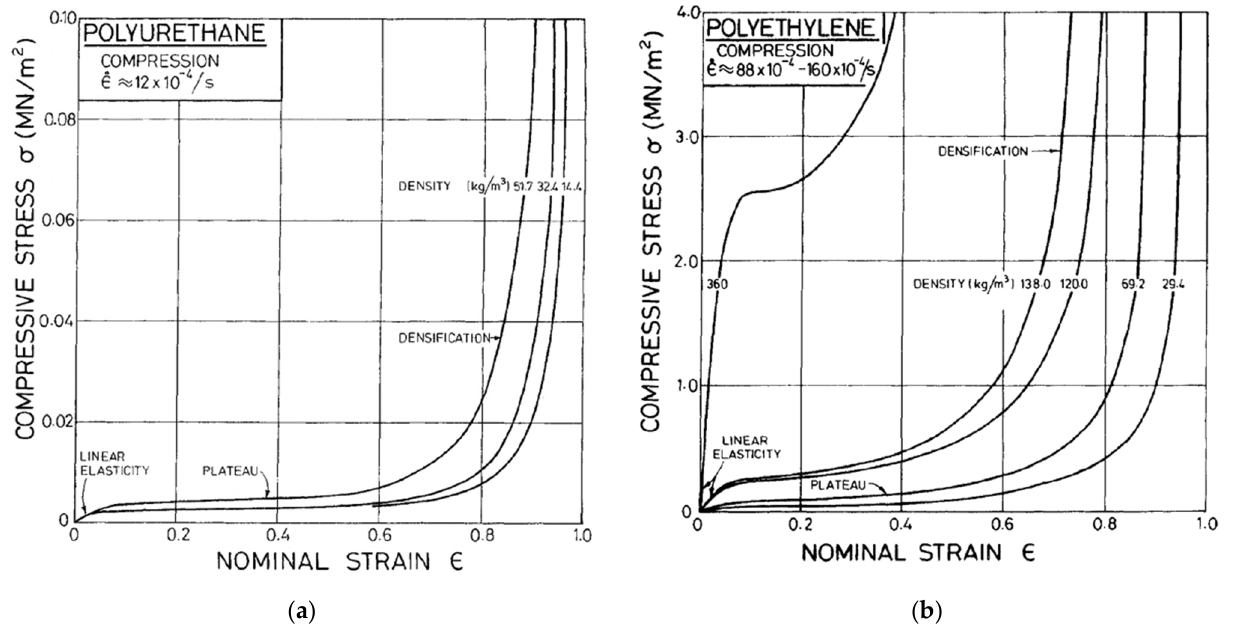
Figure 6. Experimental compressive stress–strain plots of ( a ) polyurethane foam tested at one strain rate and ( b ) polyethylene foam tested at several (low) strain rates. From [80]. Note also that due to the way trees grow, its mechanical properties depend on the angle between the loading direction and the grain [4,81–84] (Figures 7–9).